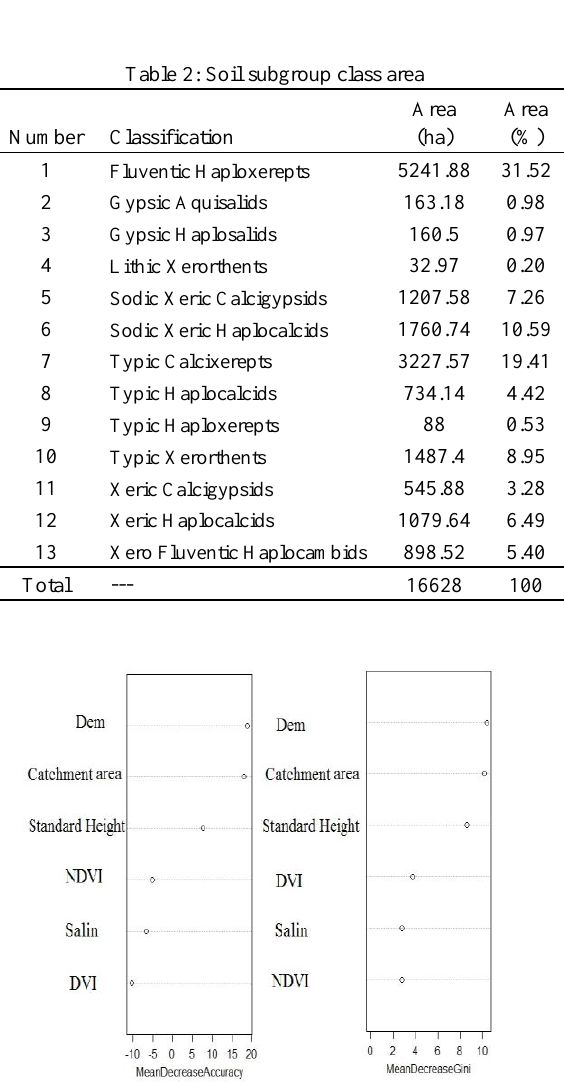
Figure 4. Relative important covariates for subgroup level based on MDA and MDG factors-VIF-RF scenario